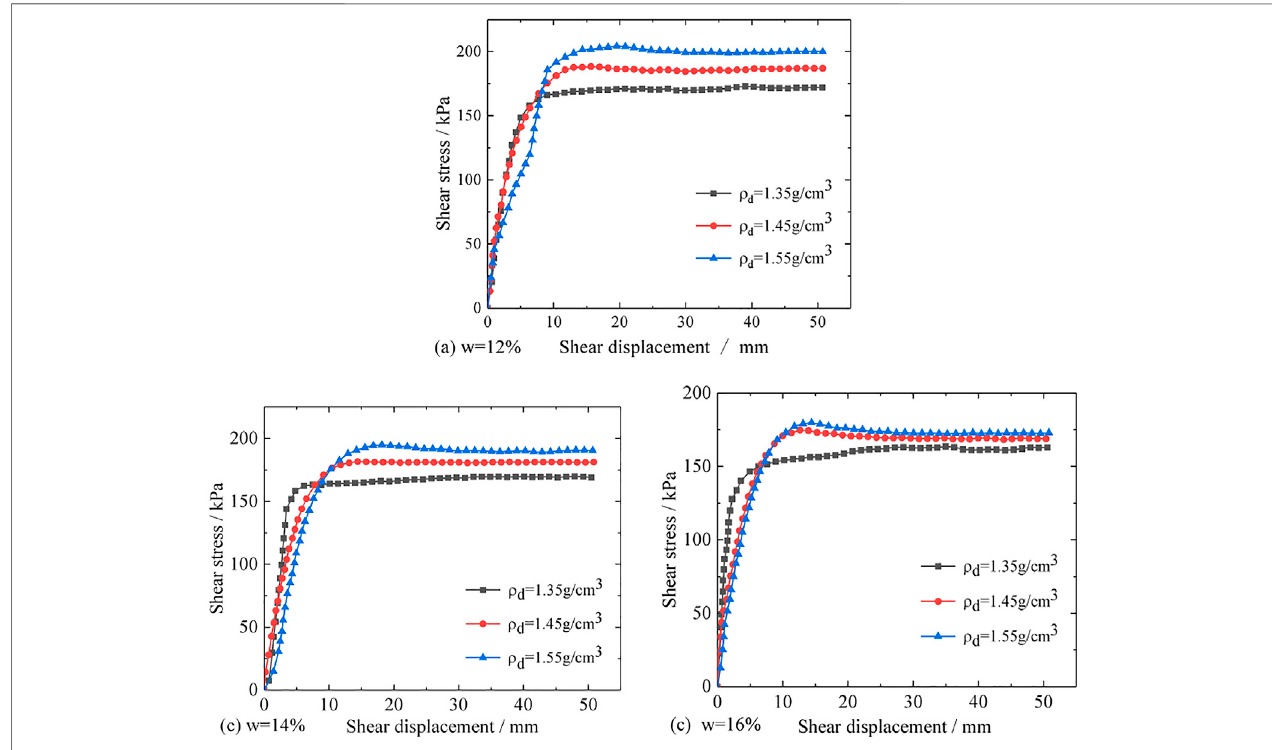
FIGURE 9 | Shear stress-shear displacement curve of specimens under different dry densities. (A) Moisture content is 12%; (B) Moisture content is 14%; (C) Moisture content is 16%.